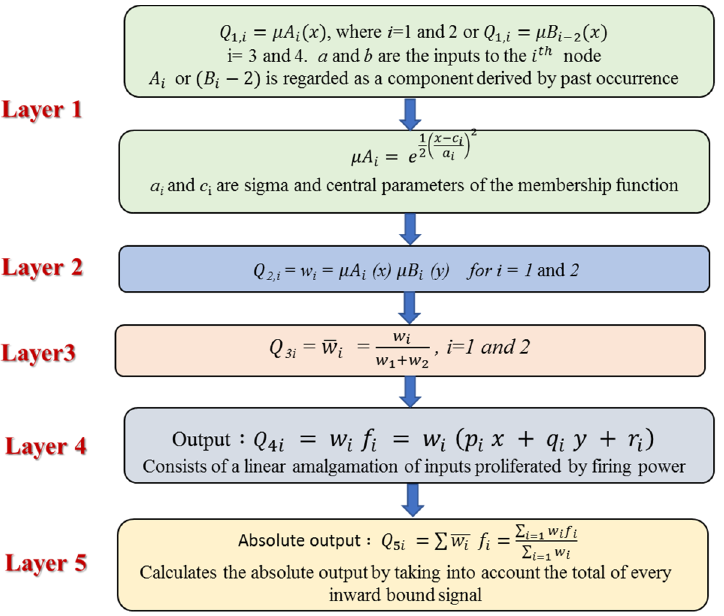
Figure 5. A schematic diagram of the five layers that incorporate ANFIS.